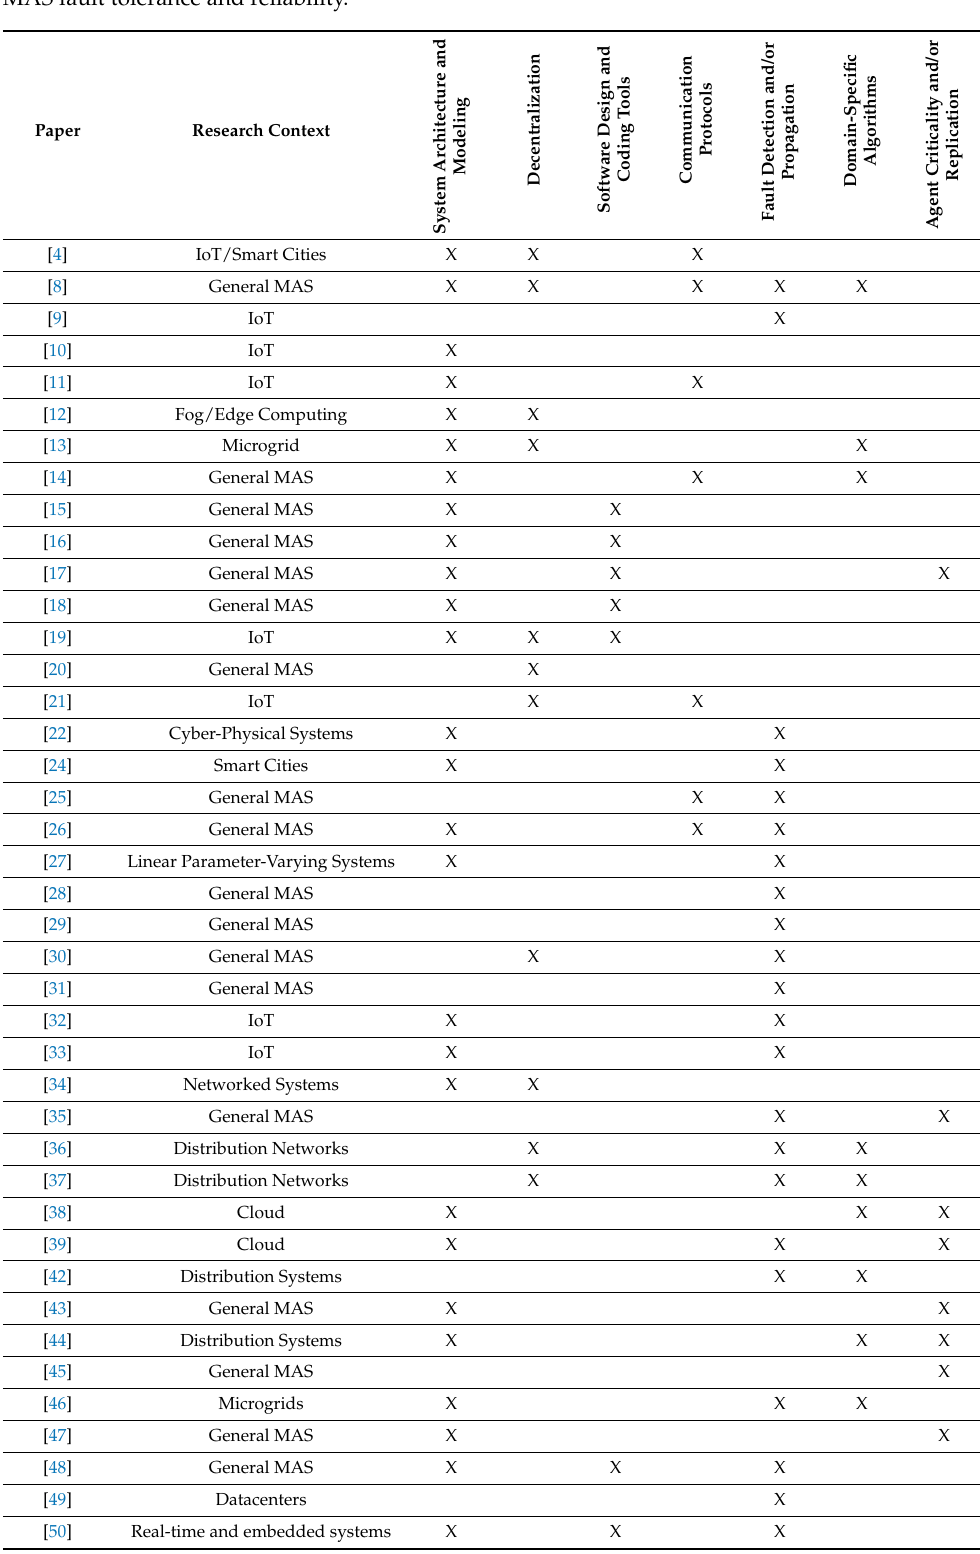
Table 1. Relative comparison table showing how existing studies have approached the problem of MAS fault tolerance and